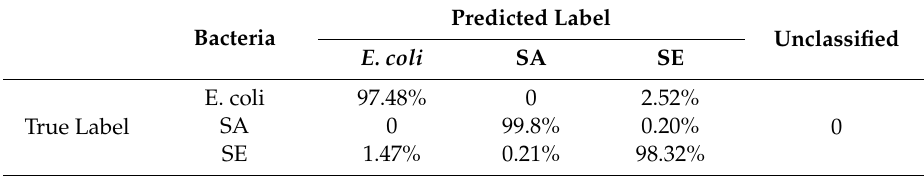
Figure 3. Wavelength selected by competitive adaptive reweighted sampling (CARS). Table 4. Confusion matrix of training set for CARS-GOA-SVM simplified